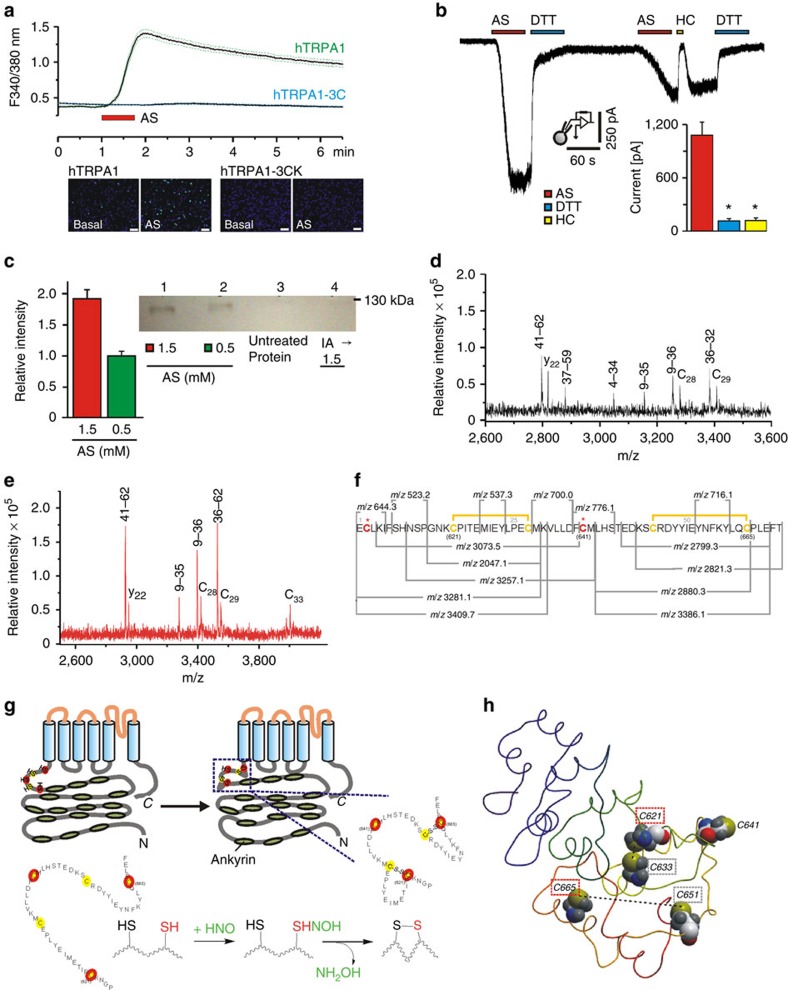
HNO activates TRPA1 via disulphide bond formation.(a) AS (300 μM, 45 s) increases intracellular Ca2+ in hTRPA1-transfected HEK cells but not in cells expressing hTRPA1-3C; mean±s.e.m., n=250 cells for each group. Representative pseudocolor images (scale bar, 100 μm). (b) AS-evoked inward currents (n=7) can be reversed by application of DTT (5 mM, 60 s), or temporarily blocked by HC030031 (50 μM, 10 s). Inset: AS (400 μM)-evoked peak inward currents are significantly reduced by HC030031 or DTT (analysis of variance following honestly significant difference post hoc test, P<0.001 each; n=7; error bars represent s.e.m.). (c) Detection of disulphide bond formation on purified mTRPA1 channel protein (100 μM) treated with AS, using modified biotin-switch assay. Lane 1: TRPA1 treated with 1.5 mM AS, lane 2: TRPA1 treated with 0.5 mM AS, lane 3: untreated protein, lane 4: TRPA1 pretreated with IA and then treated with 1.5 mM AS. (d,e) MALDI-TOF MS of AS-treated TRPA1 synthetic peptide. Peptide fragments containing cysteine residues differ in AS-treated (black, d) and control (red, e) samples. The same fragmenting pattern is observed in both cases but with m/z of the AS-treated fragments being shifted towards lower masses (by m/z 116=2IA+2H), indicating formation of disulphides. (f) Amino-acid sequence of synthetic peptide used in the study to mimic the part of hTRPA1 N terminus with critical, that is, activating cysteines and a rationale for deciphering disulphide bond positions based on observed fragments. Yellow marked cysteine residues form disulphide bonds and red cysteine residues are found to be modified by IA even after exposure to AS. (g) Schematic model of TRPA1 with cysteine-rich region (red dots) and formation of disulphide bonds causing major conformational changes. Chemical structure (bottom) of two cysteine-SH residues reacting with HNO to form hydroxylamine (NH2OH) and a disulphide bond and causing conformational change. (h) Ab initio model of the 200 amino acid long polypeptide chain of the N terminus of hTRPA1 displaying five essential cysteine residues and two indicated disulphides (dotted lines).